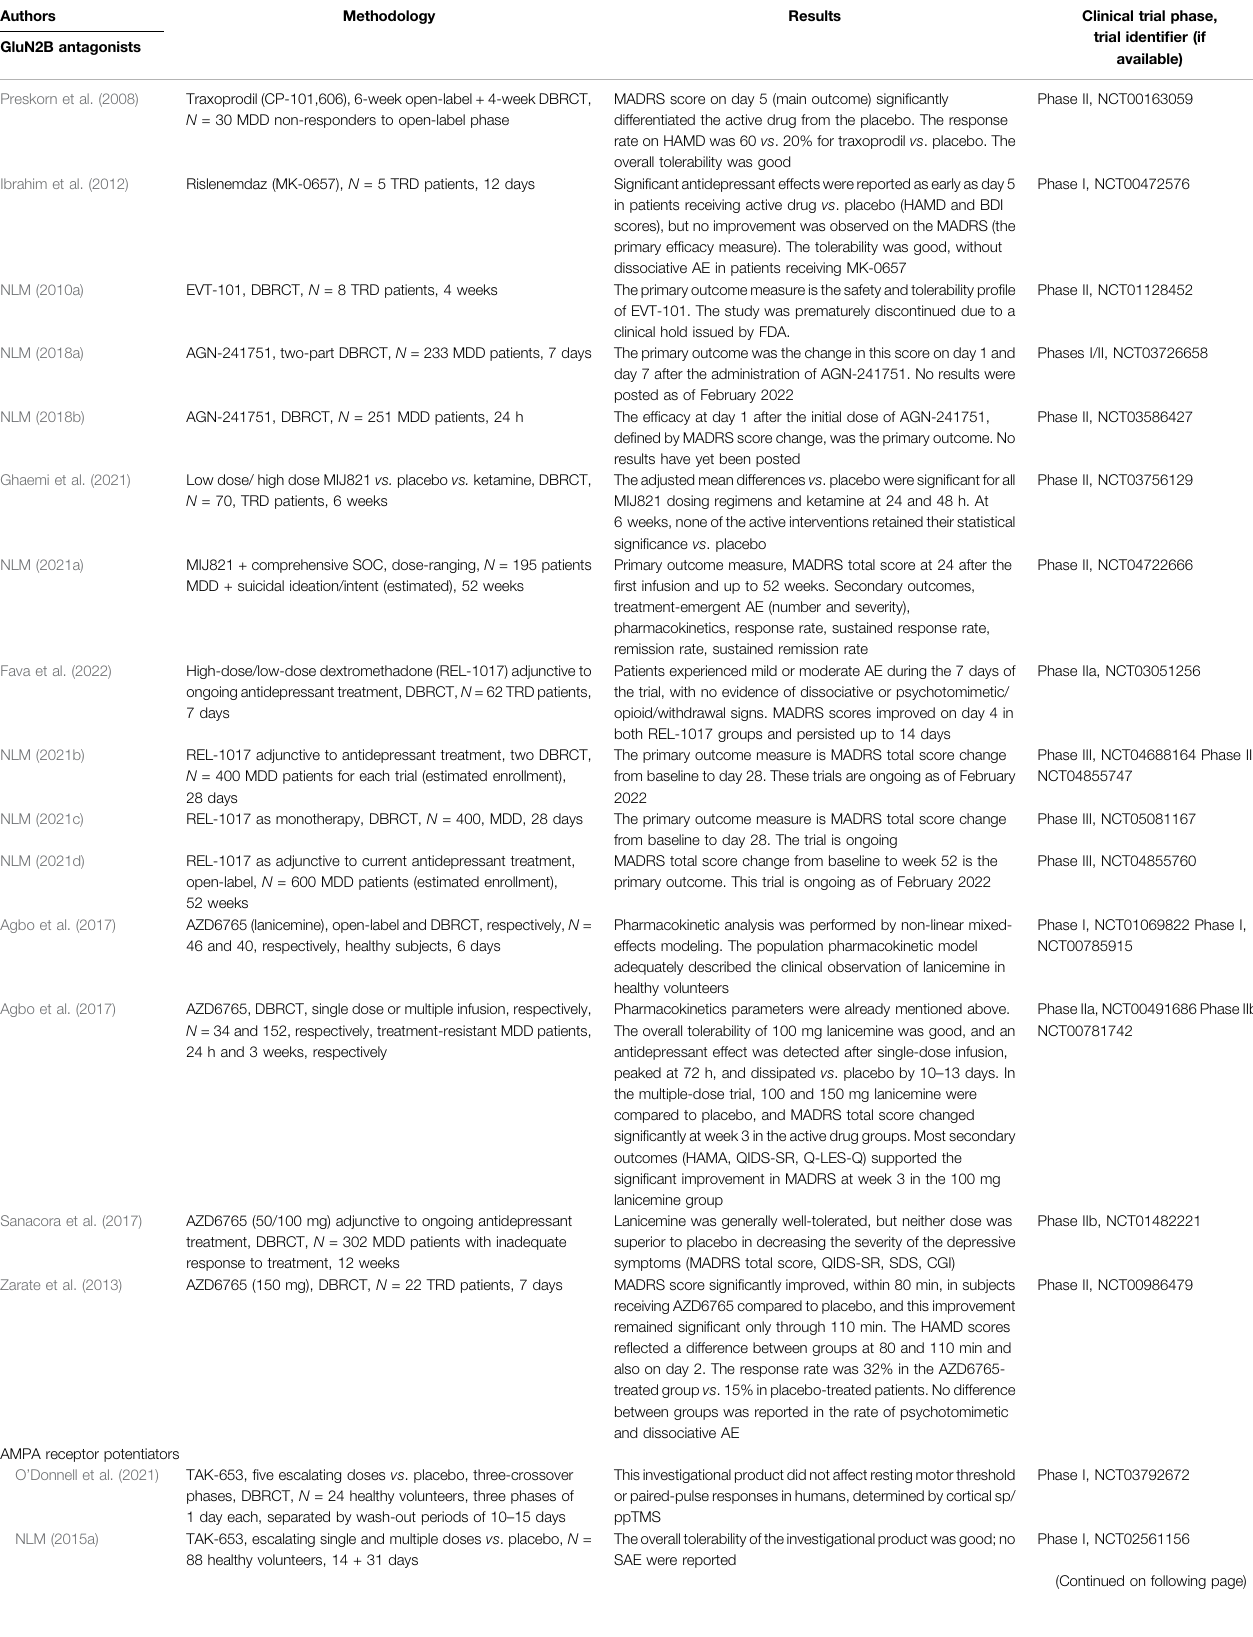
TABLE 1 | Glutamatergic agents with antidepressant properties in the pipeline.